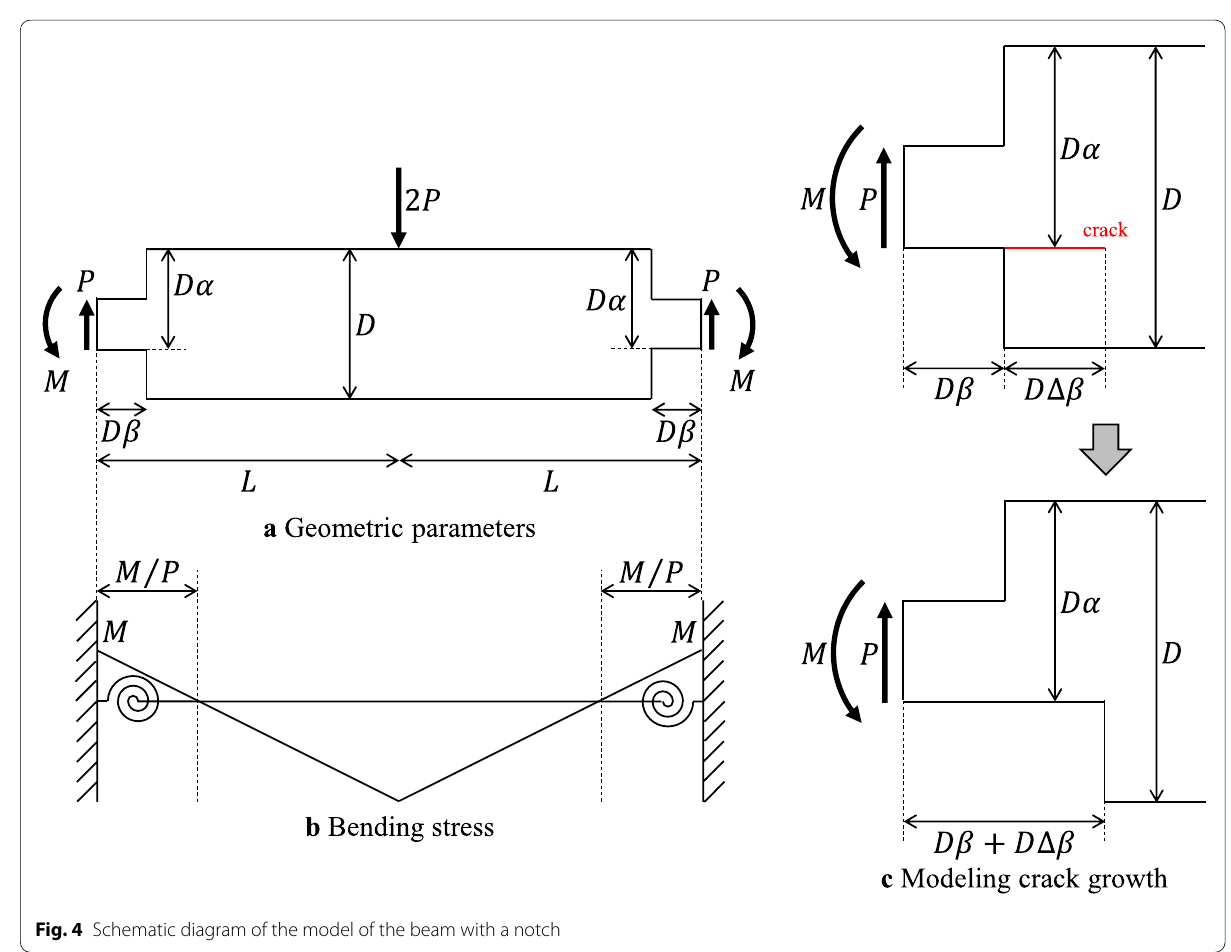
Fig. 4 Schematic diagram of the model of the beam with a